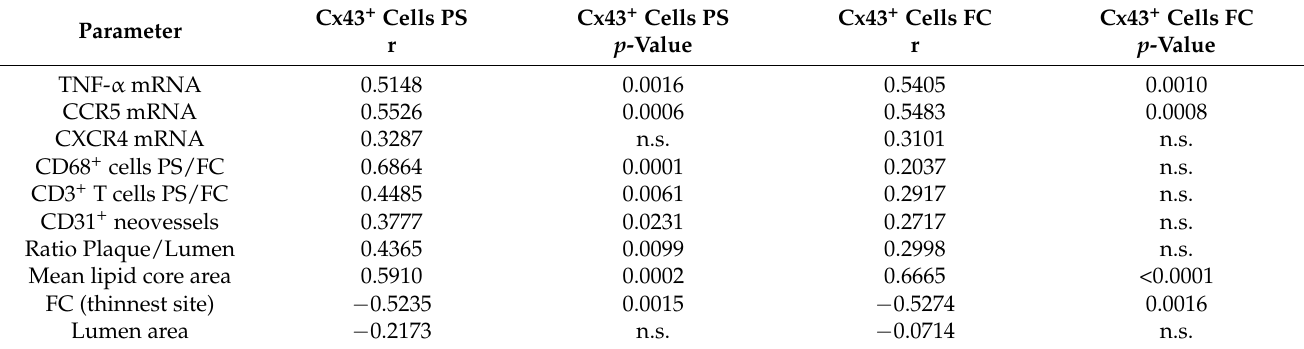
Table 2. Spearman correlation coefficient r of human plaque